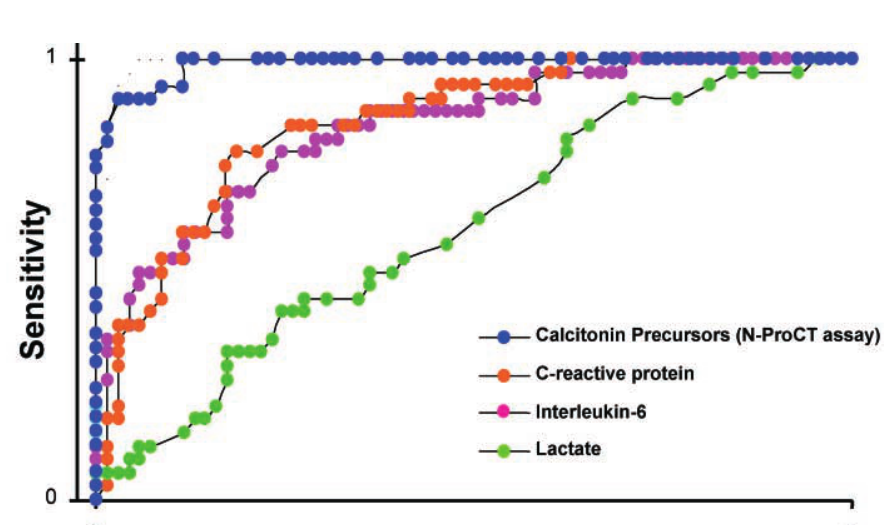
Schematic illustration of the human calcitonin precursors (procalcitonin and its constituent peptides), which are found in the free form in normal human serum. Mainly in thyroidal C-cells, immature calcitonin is amidated into mature calcitonin by the enzyme peptidyl- glycine-amidating-monooxygenase (PAM). CCP-I denotes calcitonin carboxypeptide-I. In sepsis these peptides are variably increased, often to very high levels. However, in this condition, serum levels of mature calcitonin remain normal or are only slightly